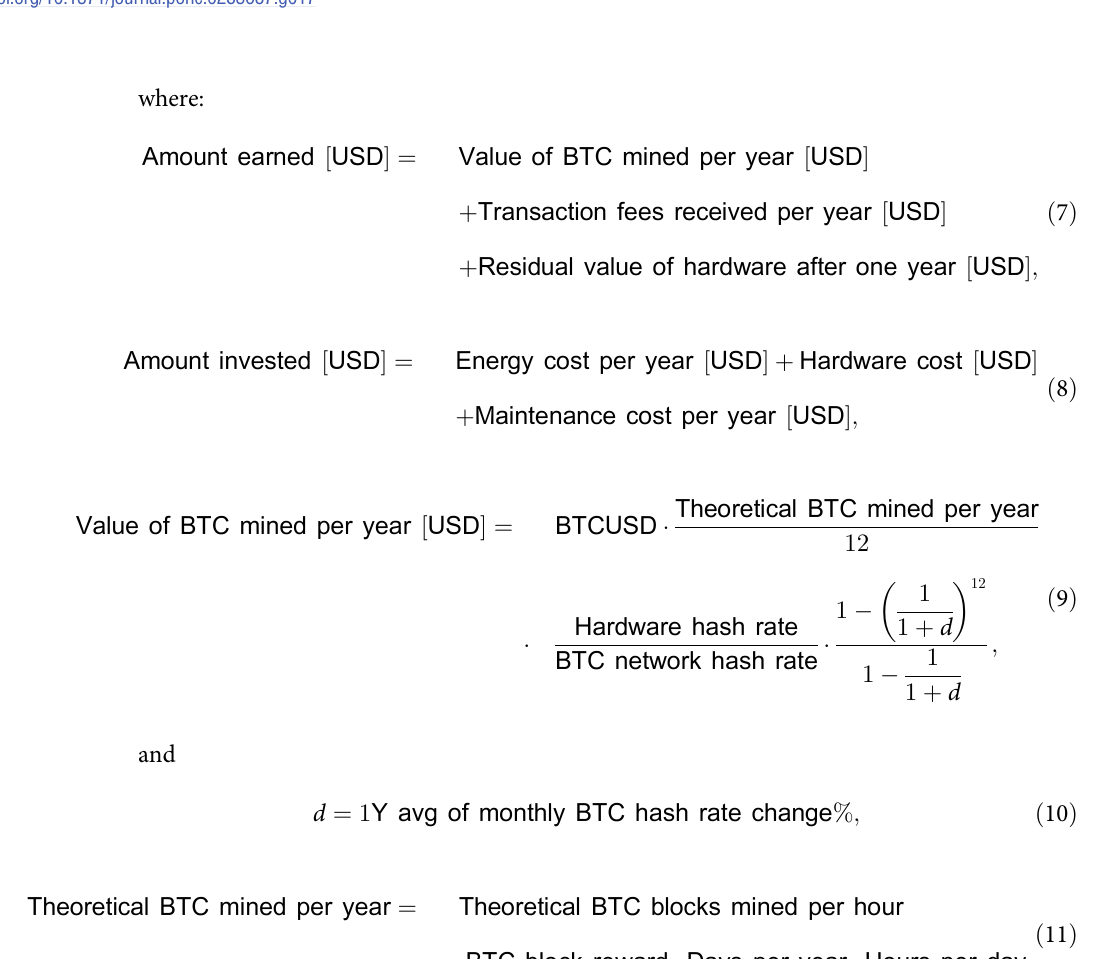
Fig 17. Fees% and 1Y average of Fees%. Note: Data covers the period between 2013/05/01 to 2021/12/03. Source: https://charts.coinmetrics.io/ network-data/.